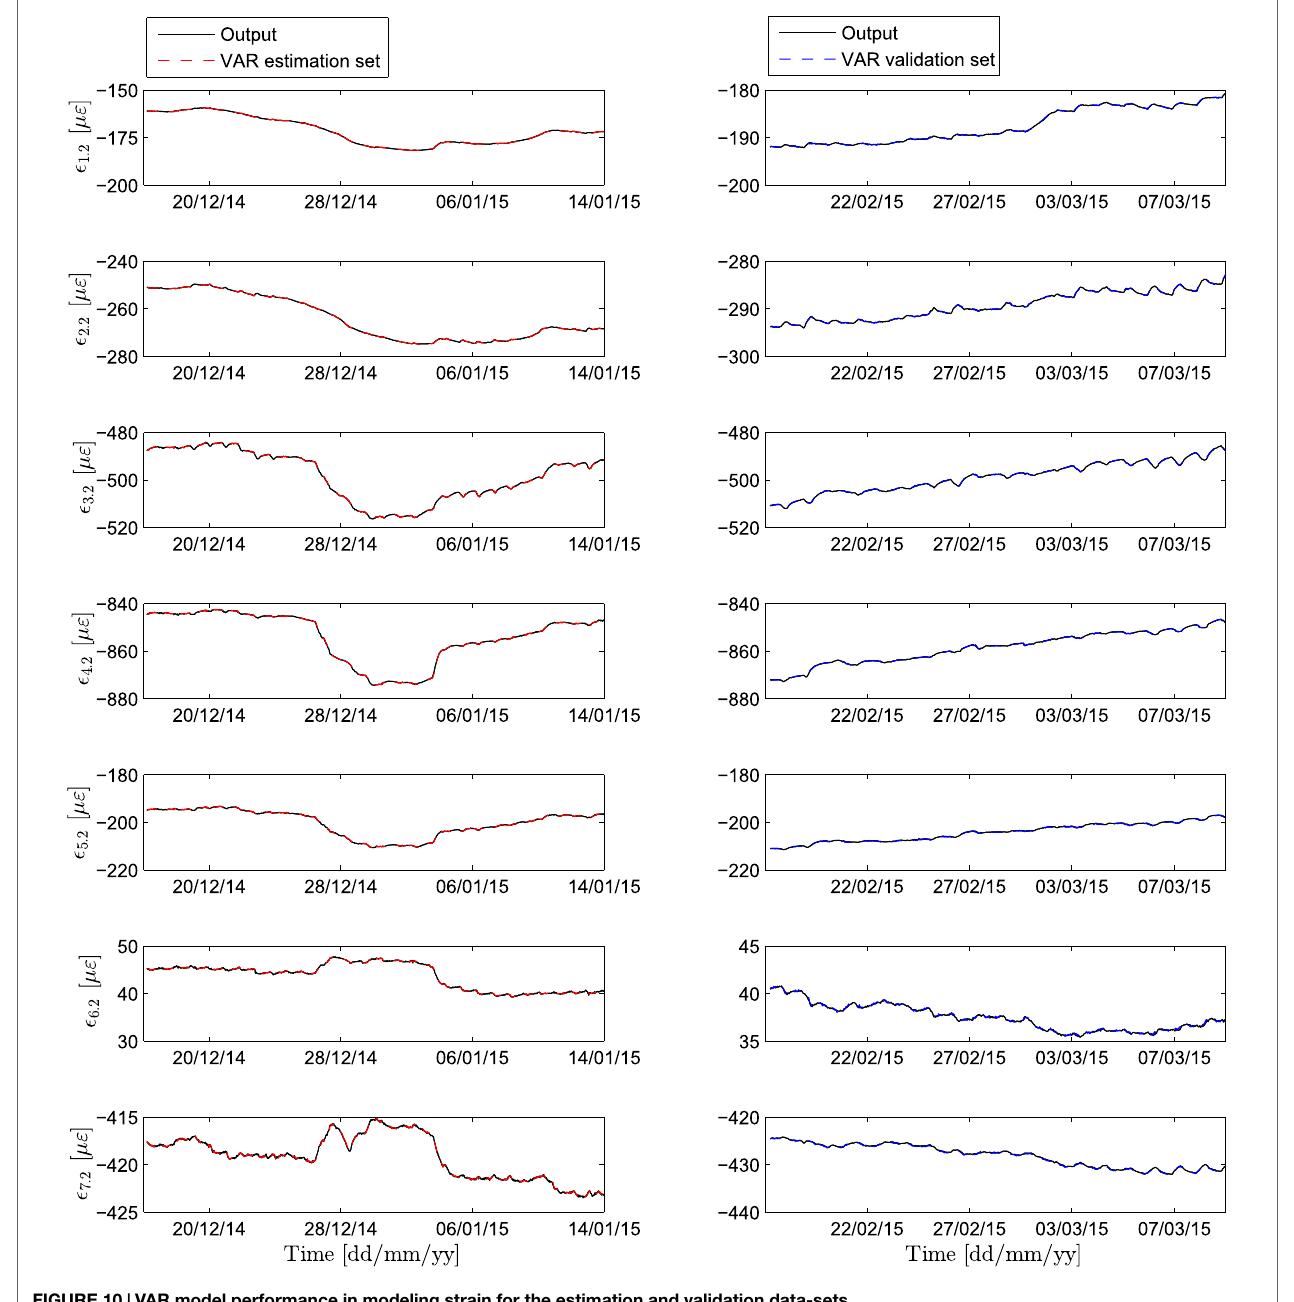
FIGURE 10 | VAR model performance in modeling strain for the estimation and validation data-sets